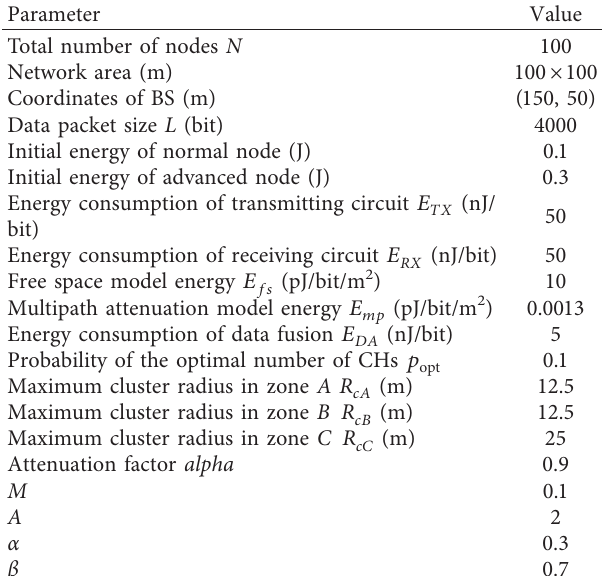
Table 1: Parameters in the simulation